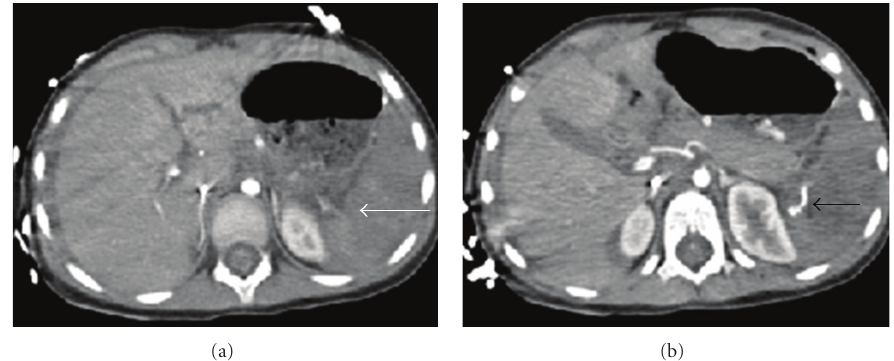
Figure 4: Contrast enhanced CT of the abdomen showing relative hypodensity of the spleen (white arrow), with extravasation of the contrast at the hilum suggestive of active bleeding (black